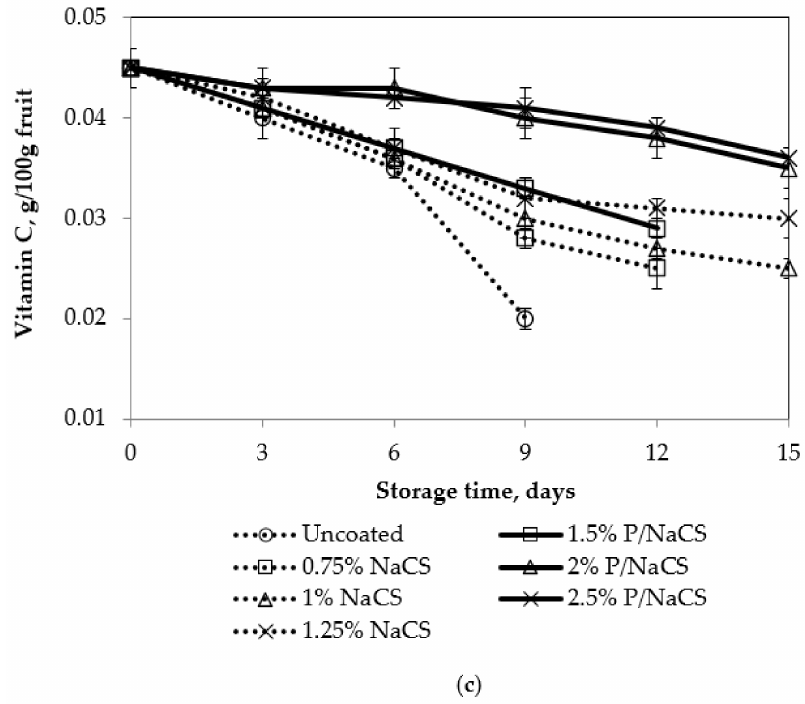
Figure 6. Effect of coating on chemical characteristics of mango fruits. Numbers are the mean ± standard errors of three replications. ( a ) TSS, ( b ) TA, and ( c ) vitamin